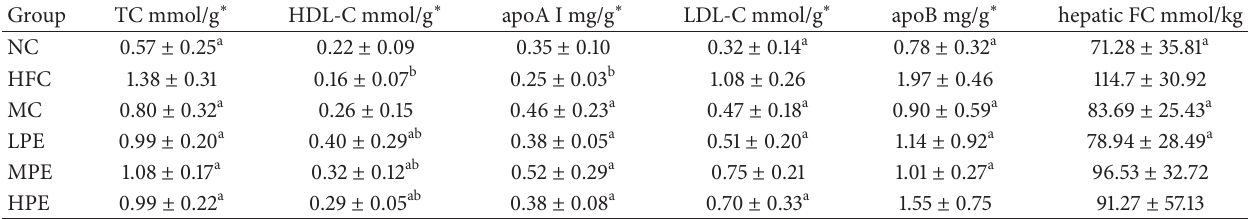
Table 3: Liver lipid and apolipoprotein levels of the experimental rats [ 𝑛 = 10 ].